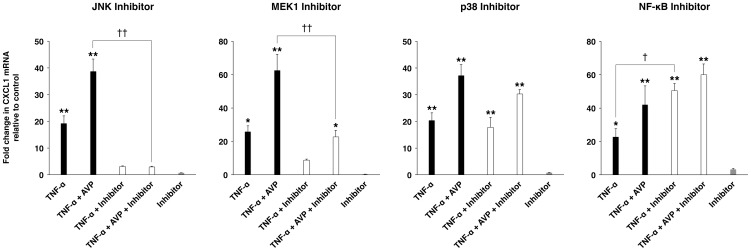
Signal transduction pathways involved in the synergistic interactions between TNF-α and AVP.The experiments were conducted on the choroid plexus epithelial cell line Z310 and changes in production of CXCL1 were assessed by real-time RT-PCR. To inhibit JNK (SP600125; 10 µM) or p38 (SB203580; 1 µM) activity, or to interfere with ERK (MEK1 inhibitor PD-98059; 10 µM) or NF-κB (SN50; 100 µg/ml) signaling, the Z3110 cells were pre-incubated for 1 h with respective inhibitors. These inhibitors were also added to the culture media when the cells were exposed to TNF-α (5 ng/ml) or a combination of TNF-α (5 ng/ml) and AVP (1 nM) for an additional hour. Note that the selective JNK inhibitor SP600125 completely abolished the induction of CXCL1 synthesis observed in response to TNF-α alone or to a combination of TNF-α and AVP. A selective MEK1 inhibitor PD-98059 partially (by >50%) inhibited CXCL1 synthesis, whereas p38 inhibitor SB203580 had no effect. In comparison, the inhibition of NF-κB signaling resulted in the amplification of chemokine synthesis. *p<0.05, **p<0.01 for treatment versus control. †
p<0.05, ††
p<0.01 for the incubation with inhibitor versus the incubation without inhibitor (n = 3 per group).